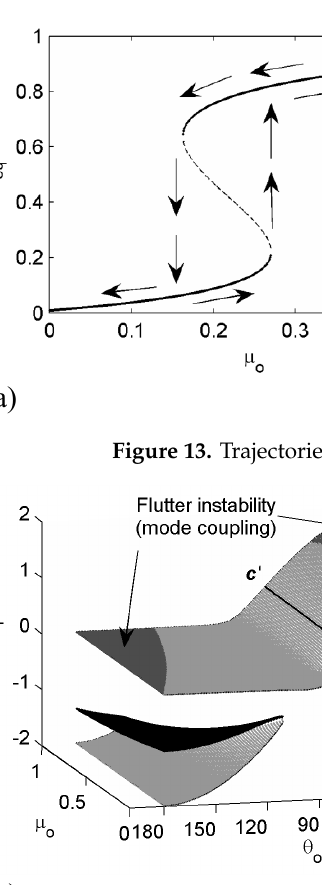
Figure 12. Bifurcation set (curve) and catastrophe for steady-sliding equilibrium at 0.1 σ = .